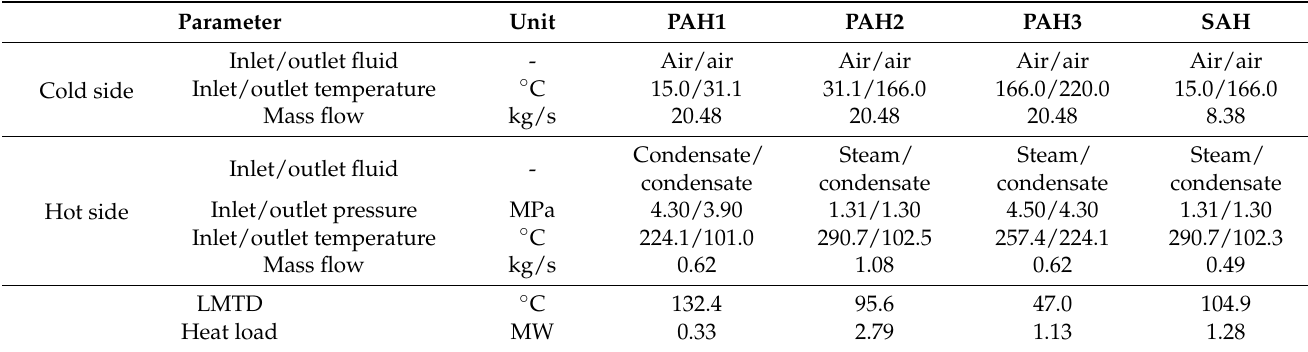
Table 3. Parameters of the APHs in WTEU.